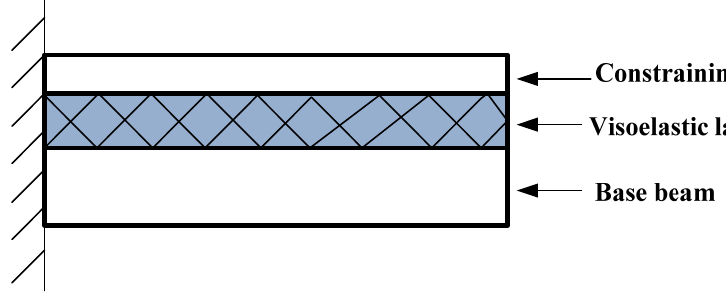
Figure 1. Elastic-viscoelastic-elastic sandwich beam structure.